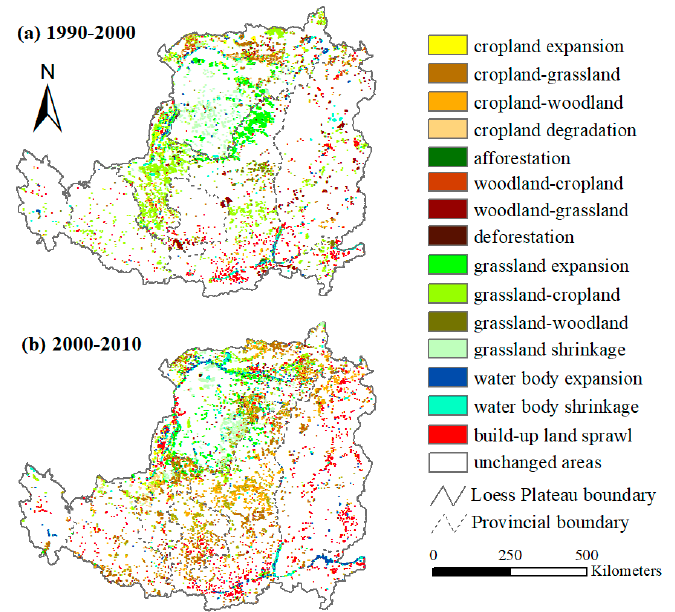
Figure 5. The spatial distribution of LULCC in two periods: ( a ) from 1990 to 2000, ( b ) from 2000 to 2010. Table 1. Transition matrix of LULCC in the Loess Plateau between 1990 and 2000 (Unit: km 2 ).